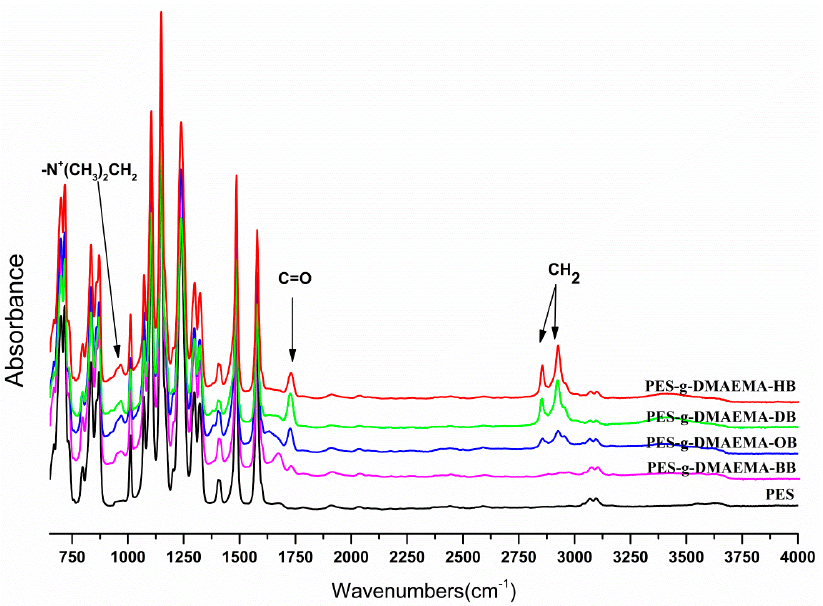
Figure 2. ATR-FTIR of the initial and modified PES membranes prepared with four quaternary ammonium salts monomers.